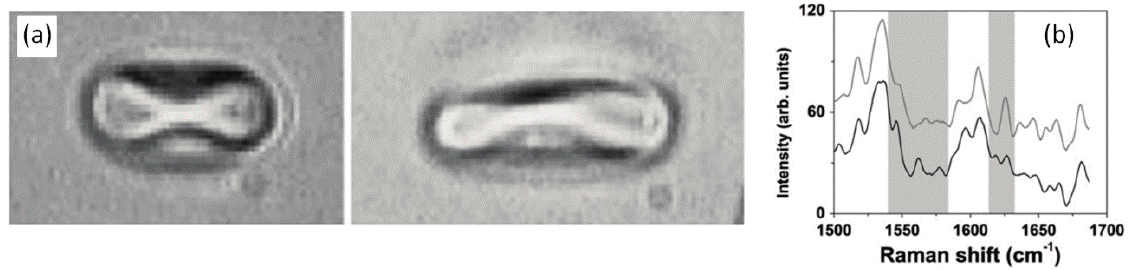
Figure 9. ( a ) A red blood cell is stretched using optical tweezers while the Raman spectra is monitored to gauge the cell oxygenation level; ( b ) The Raman spectra of the stretched (bottom curve) and un-stretched (top curve) blood cell. The shaded regions highlight Raman bands which were most affected by mechanical stretching [65] (With permission from